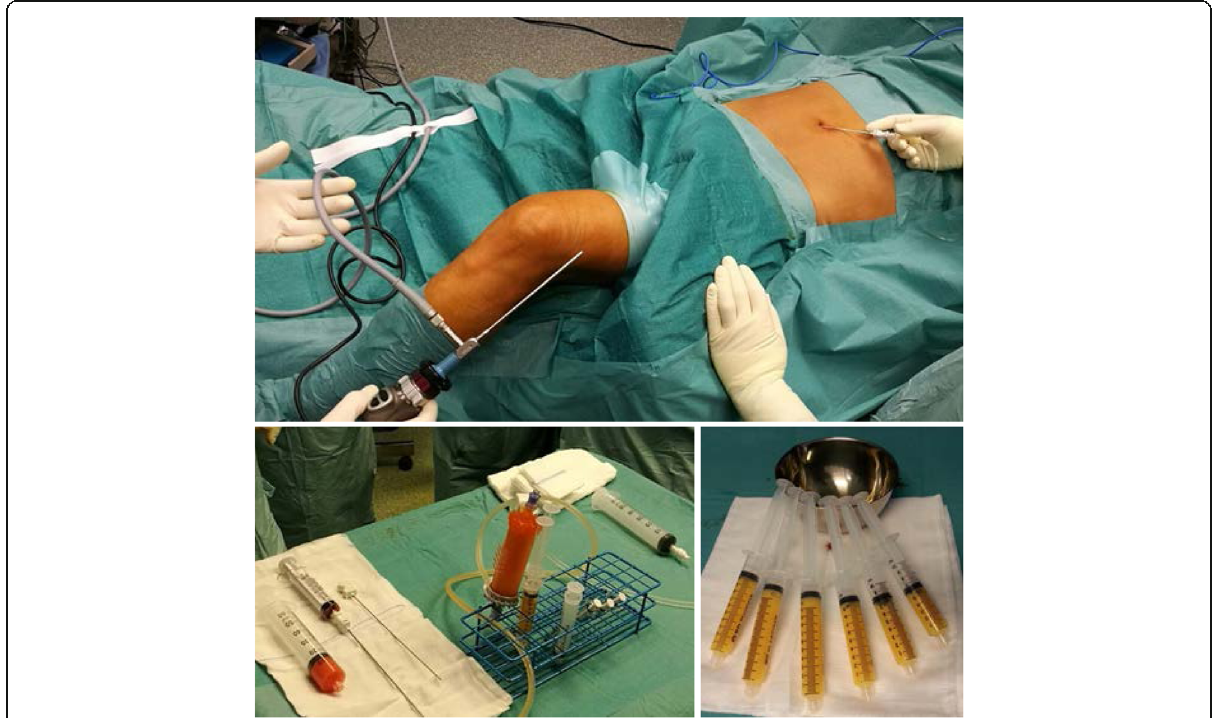
Fig. 1 Lipogems® system. Top) surgical setting. Bottom left) device. Bottom right) final